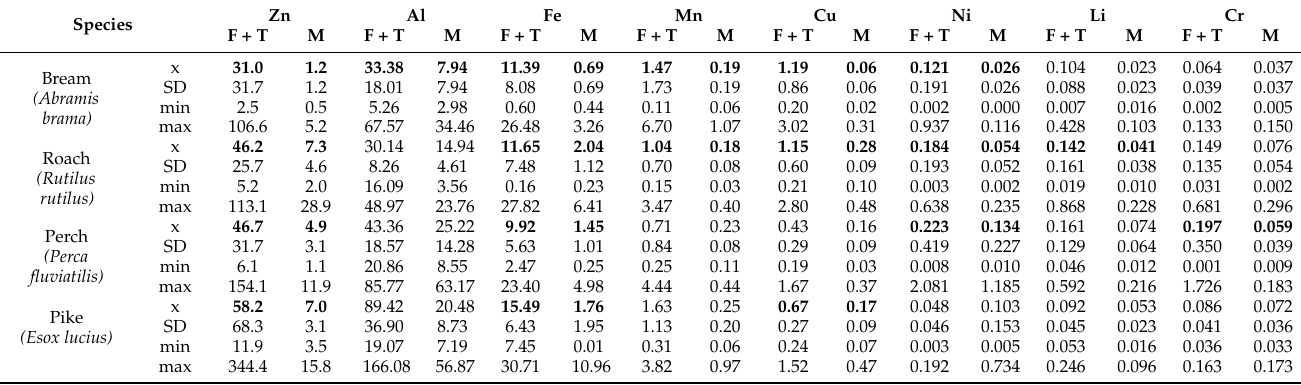
Figure 3. Differences (x ± SD) among species (small letters) in the content of toxic metals among female gonads ( ), testicles ( ) and muscles (M) of the bream (B), roach (R), perch (Pe), and pike (P). ♀ ♂ Table 2. Content of essential trace elements in female fish gonads and testicles (F + T) and muscles (M)